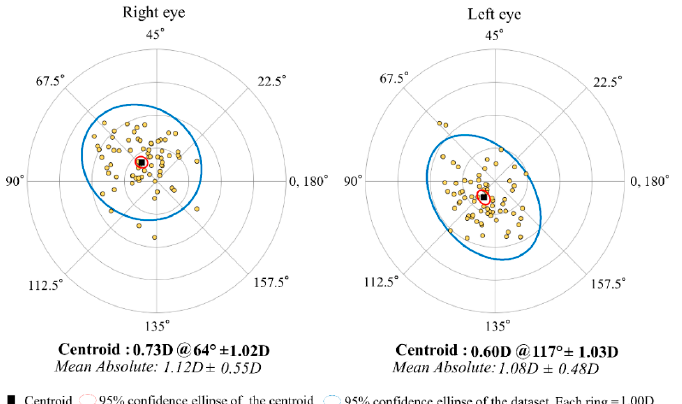
Figure 2. Graph showing the distributions of the arithmetic mean of surgically induced astigmatism (M-SIA).